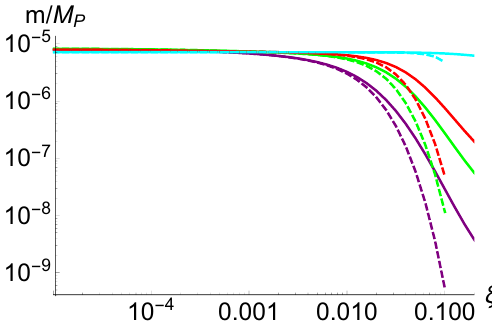
Figure 8. m vs. ξ for δ = 40 , 70 , 100 , 1000 respectively in purple, green, red and cyan with N e = 50 e -folds in region 2. Continuous/dashed line represents metric/Palatini